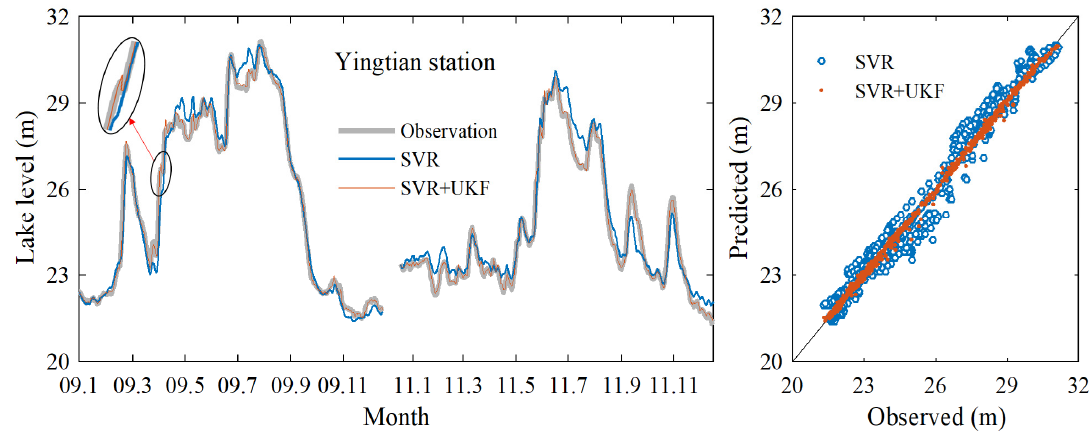
Water 2022 , 14 , x FOR PEER REVIEW Figure 7. Comparisons between Yingtian water levels predicted with SVR and SVR+UKF. Figure 7. Comparisons between Yingtian water levels predicted with SVR and SVR+UKF. Figure 7. Comparisons between Yingtian water levels predicted with SVR and SVR+UKF.